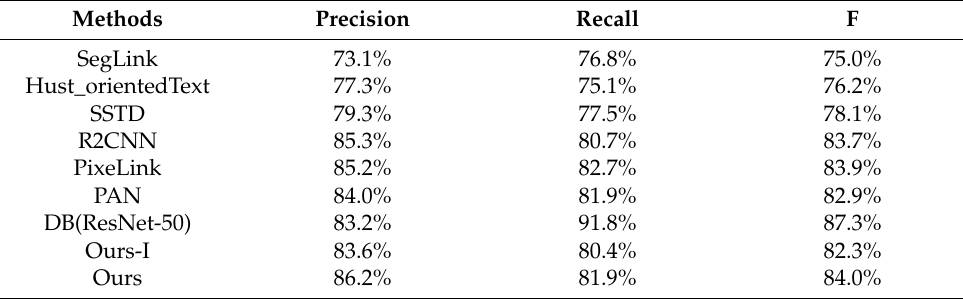
Table 1. Comparison of improved algorithm and mainstream algorithm.